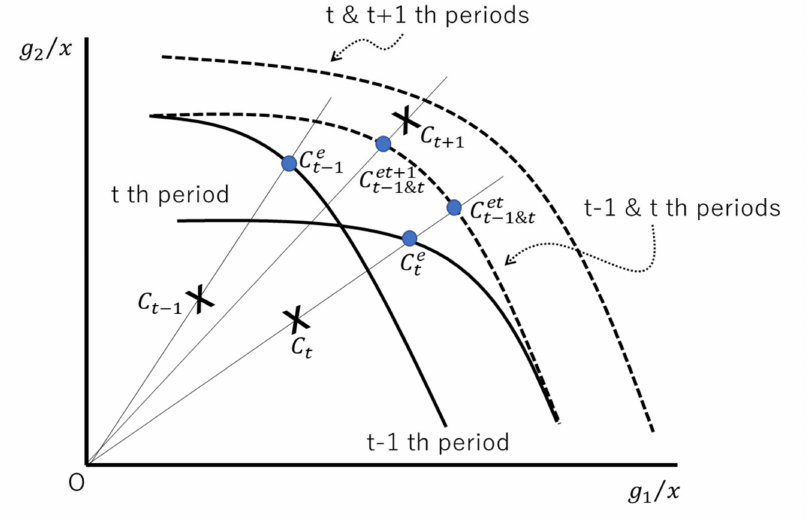
Figure 1. Visual Description of Efficiency and Index Measures (Three Periods). Note: The win- dow analysis prepares a single frontier even if multiple frontiers cross over each other. This is a methodological